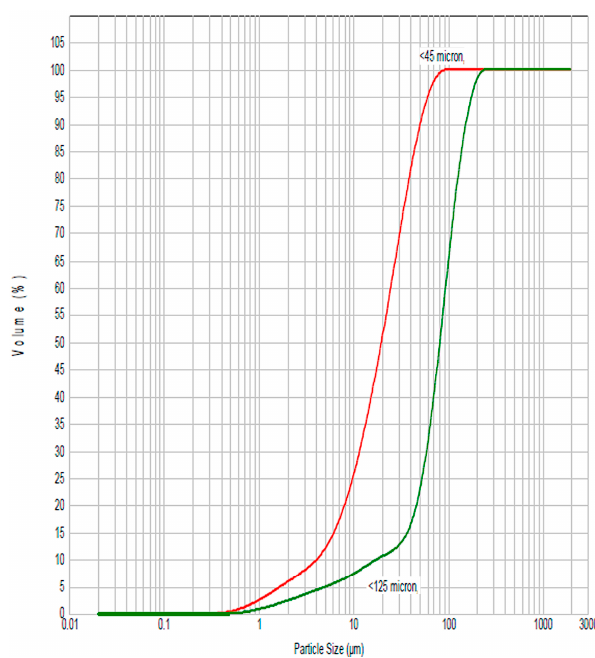
Figure 1. Grain size distribution of starting glasses sieved <45 µ m (red curve) and <125 µ m (green curve).